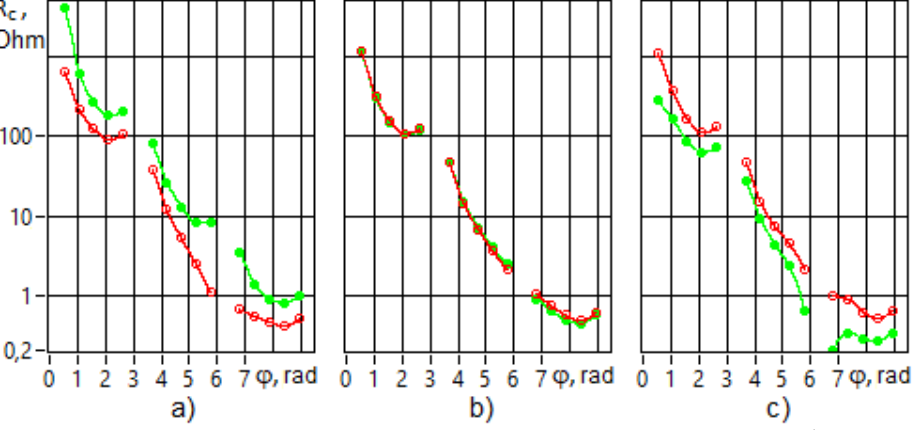
Fig. 3. The coupling impedance is “0”, “+1”, “-1” of the spatial harmonics of the cavity (⬤) and slot (O) passbands SS CCC depending on the angle of the opening of the coupling slot α s with constant period D . а) – α s = 100 0 , b) – α s = 132.42 0 , c) – α s = 190 0